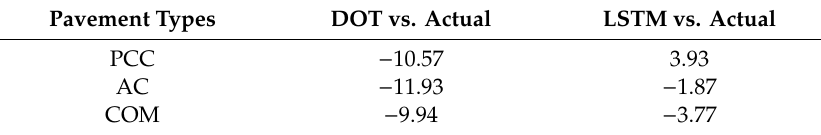
Figure 9. PCI residual vs. age in PCC pavements. Table 5. Mean of errors for DOT and LSTM